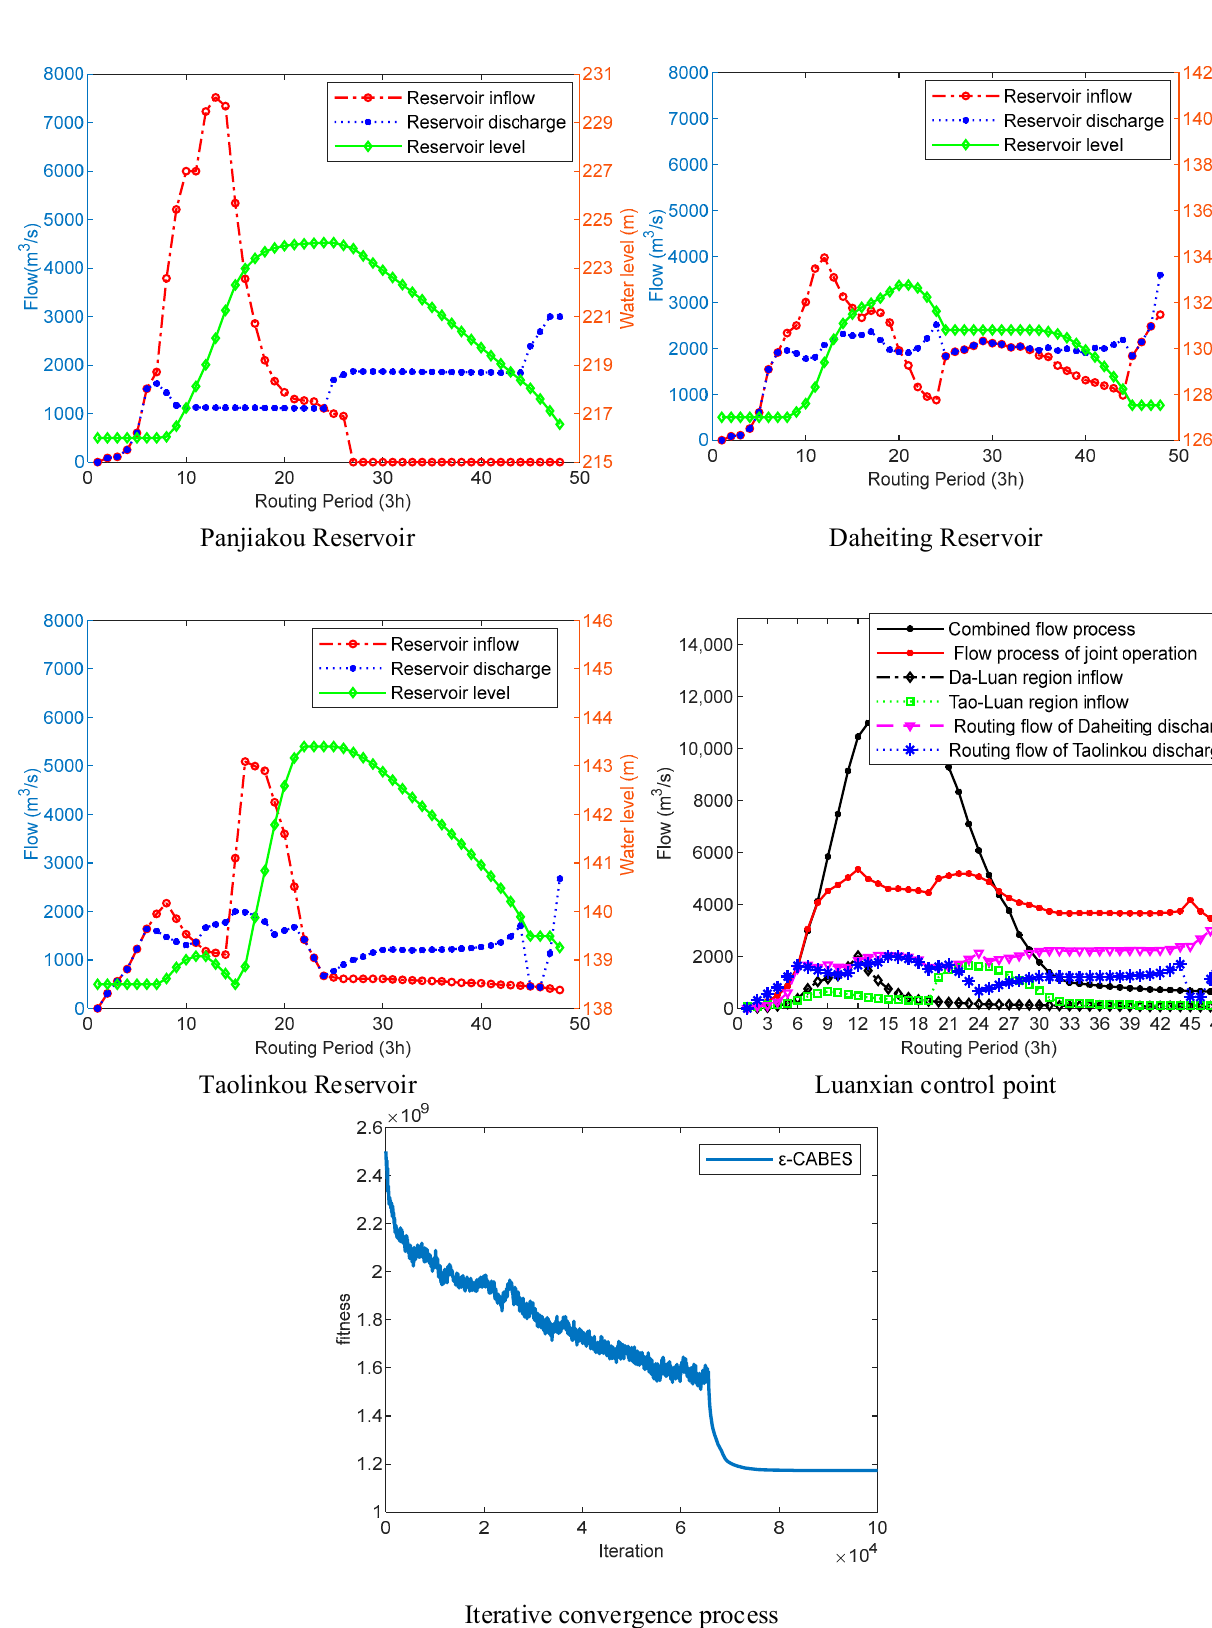
Figure 5. Operation process using ε -CABES for reservoirs in Luanhe River Basin.